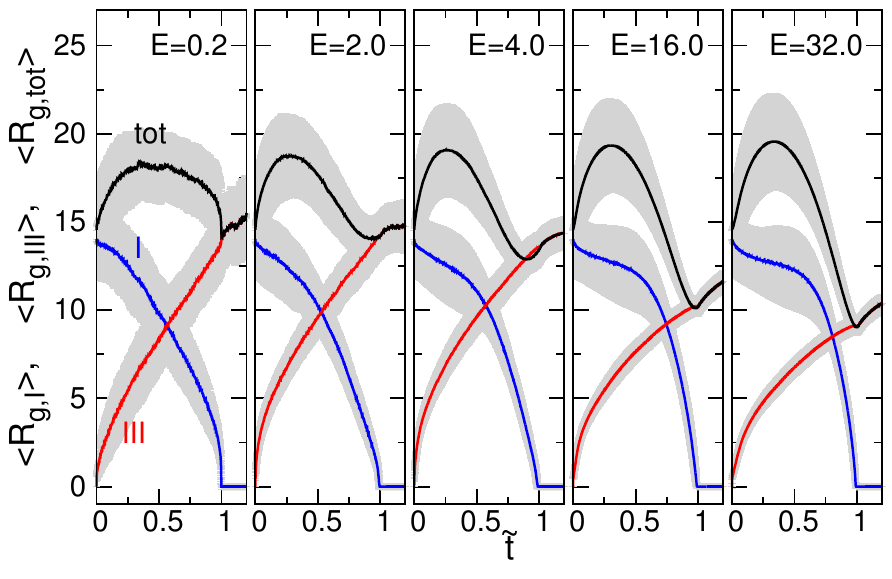
Figure 5. ˜ t -variation of the averaged R g for the chain of N = 128 in the cis-(I), the trans-(III), and the whole (tot) region at E = 0.2, 2.0, 4.0, 16.0, and 32.0. The gray-colored region denotes the distribution range of a curve.